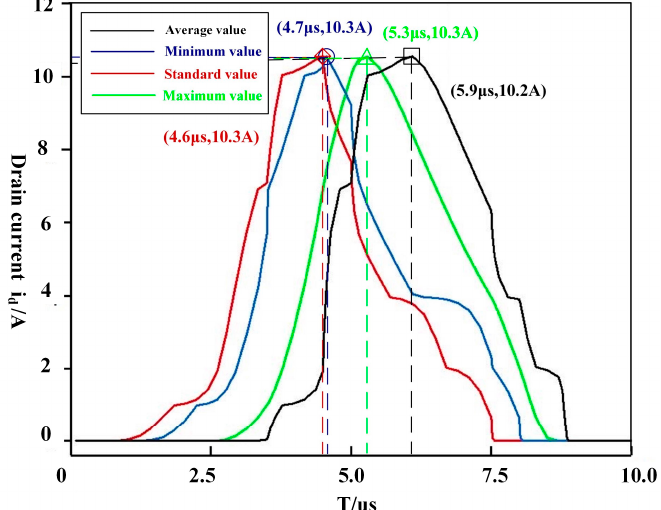
Figure 8. Simulation curves of i d and the maximum, standard, average, minimum values of L d .